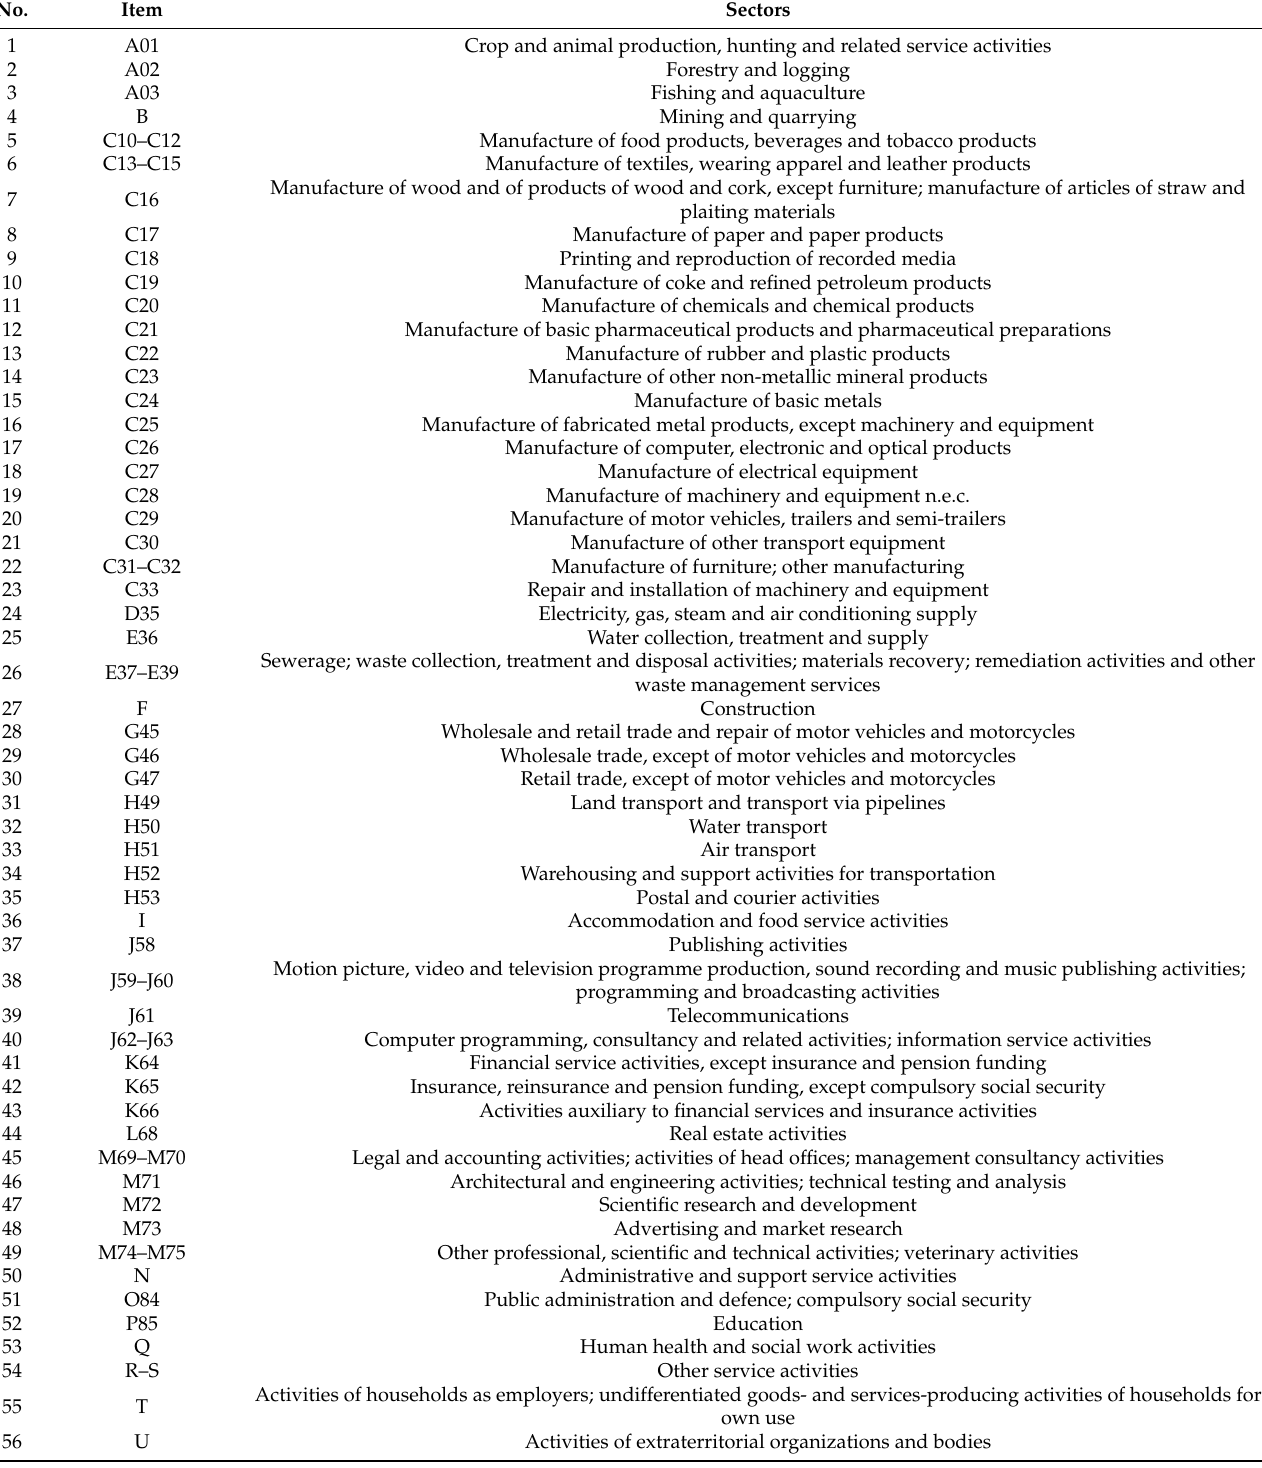
Table 1. List of sectors